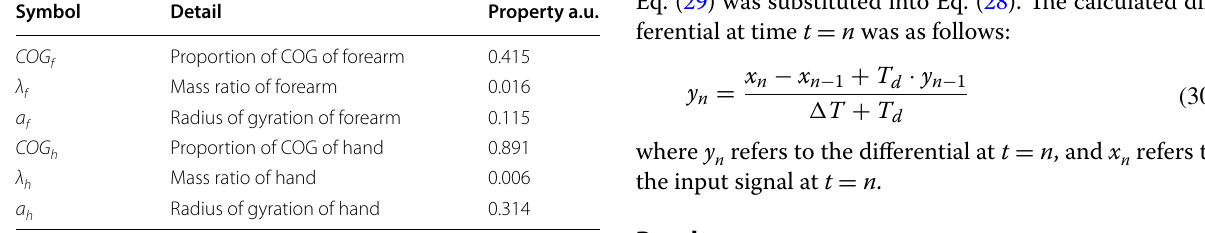
Table 5 Physical properties of forearm and hand Symbol Detail Property a.u.